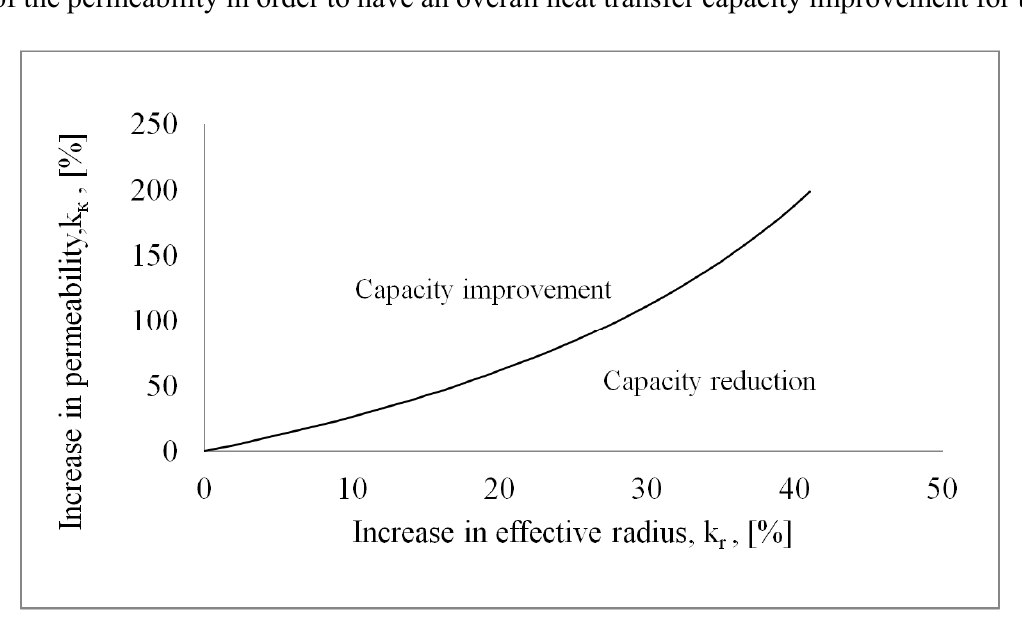
Figure 11. Pore former evaluation